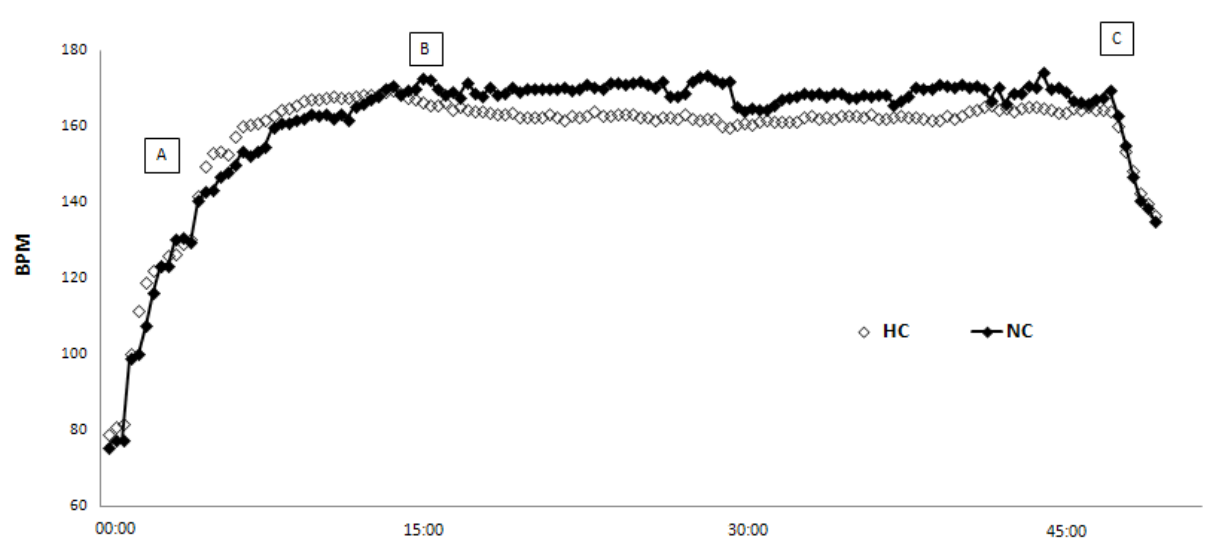
Figure 3. Pattern of the heart rate in beats per minute (BPM); the data are represented by means. Caption: A- Transition from rest to activity; B- Adjustment to exercise intensity for the hypoxia group (reduction to warm-up speed, approximately 30% of the LV-I); C- Termination of the exercise